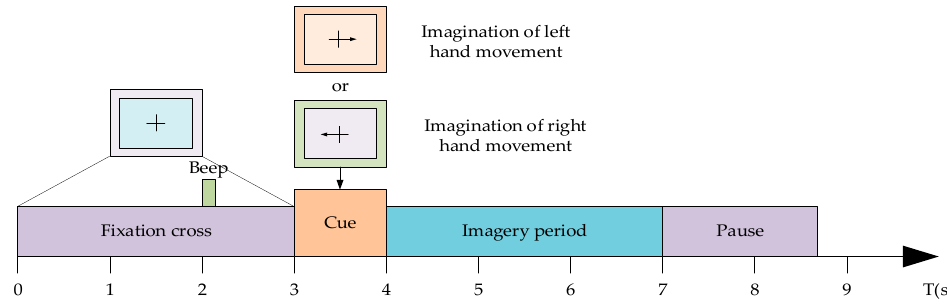
Figure 8. Feedback motion imagination without recognition results.